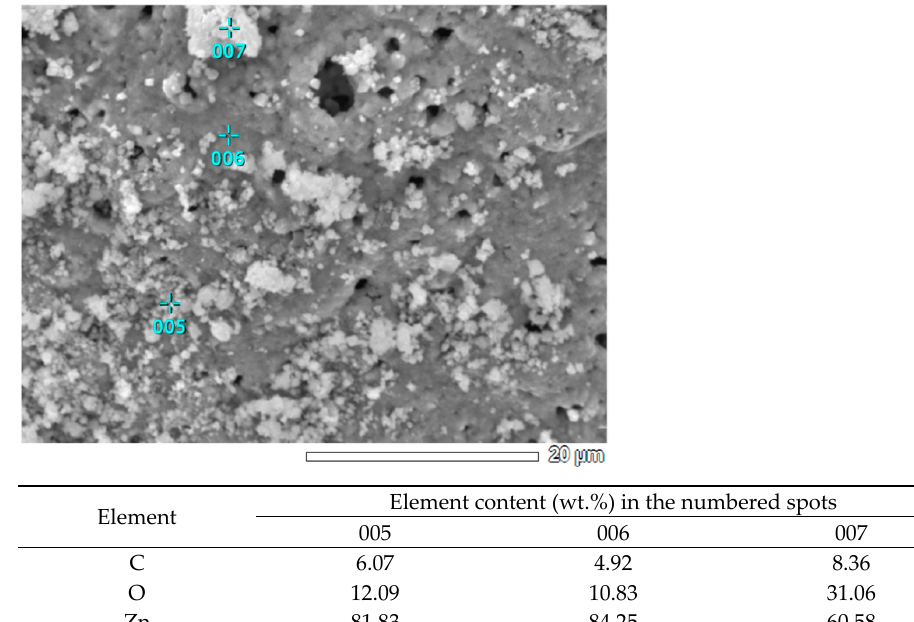
Figure 4. EDS analysis of the local elemental composition of the SCS product at φ = 0.25.